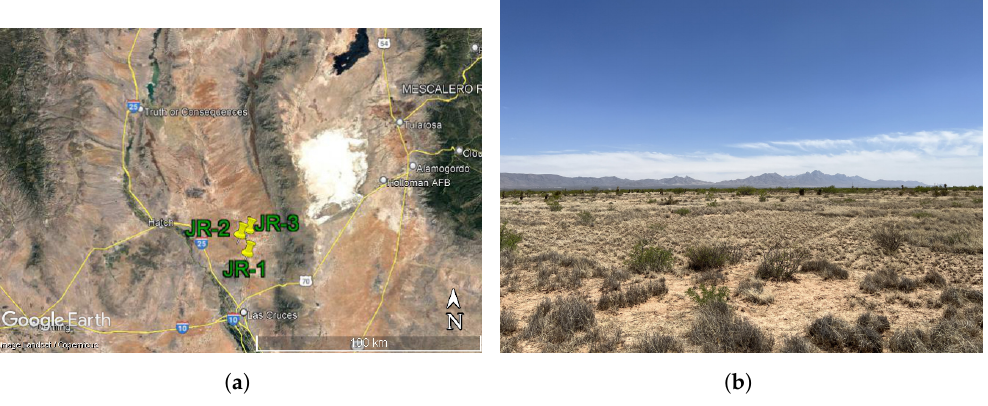
Figure 3. JER SoilSCAPE sites: ( a ) Satellite photo; ( b ) Photo of the site taken in May 2019. In each site, four nodes are equipped with four soil moisture sensors installed at 5 cm, 10 cm, 20 cm, and 30 cm depths. Sensors were installed in May 2022. Node JR-3-3 of the JR-3 site is located within 100 m of the US Climate Reference Network (USCRN) Las Cruces station [28]. These sites are mostly dry with minimal